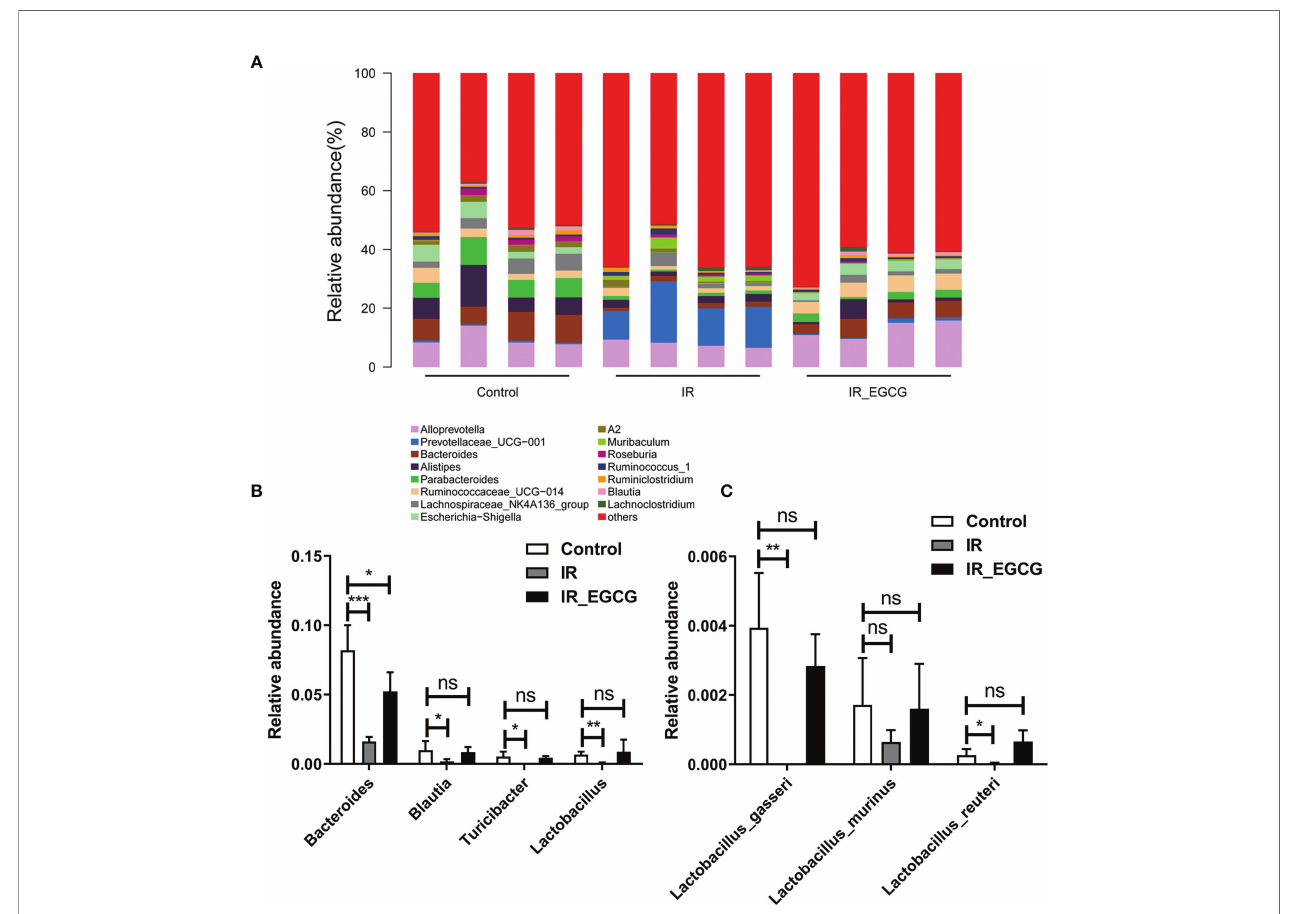
FIGURE 6 | EGCG modulates the gut microbiota composition at the genus level. (A) Distribution of bacterial genera across all groups. (B) Relative abundance of Bacteroidales , Blautia , Turicibacter and Lactobacillus in the fecal samples. (C) Relative abundance of Lactobacillus after EGCG treatment. Data are represented as the mean ± SEM. * p < 0.05; ** p < 0.01; *** p < 0.001; ns, not signi fi cant; n =